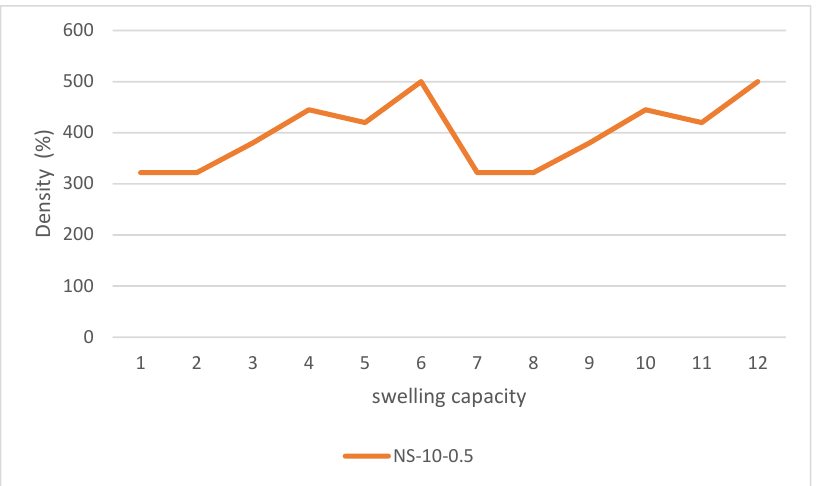
Table 1. Regression results of the models in test phase.